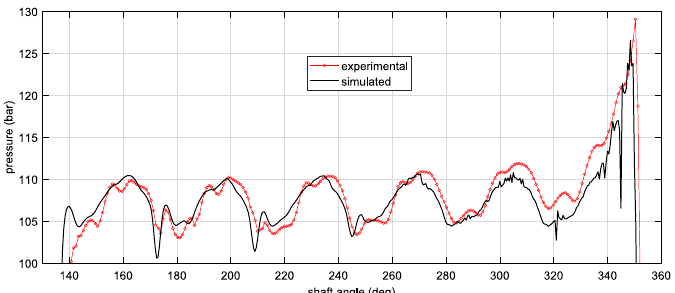
Figure 12. Detail of the pressure with plates A at 1500 rpm when the chamber is connected to the delivery